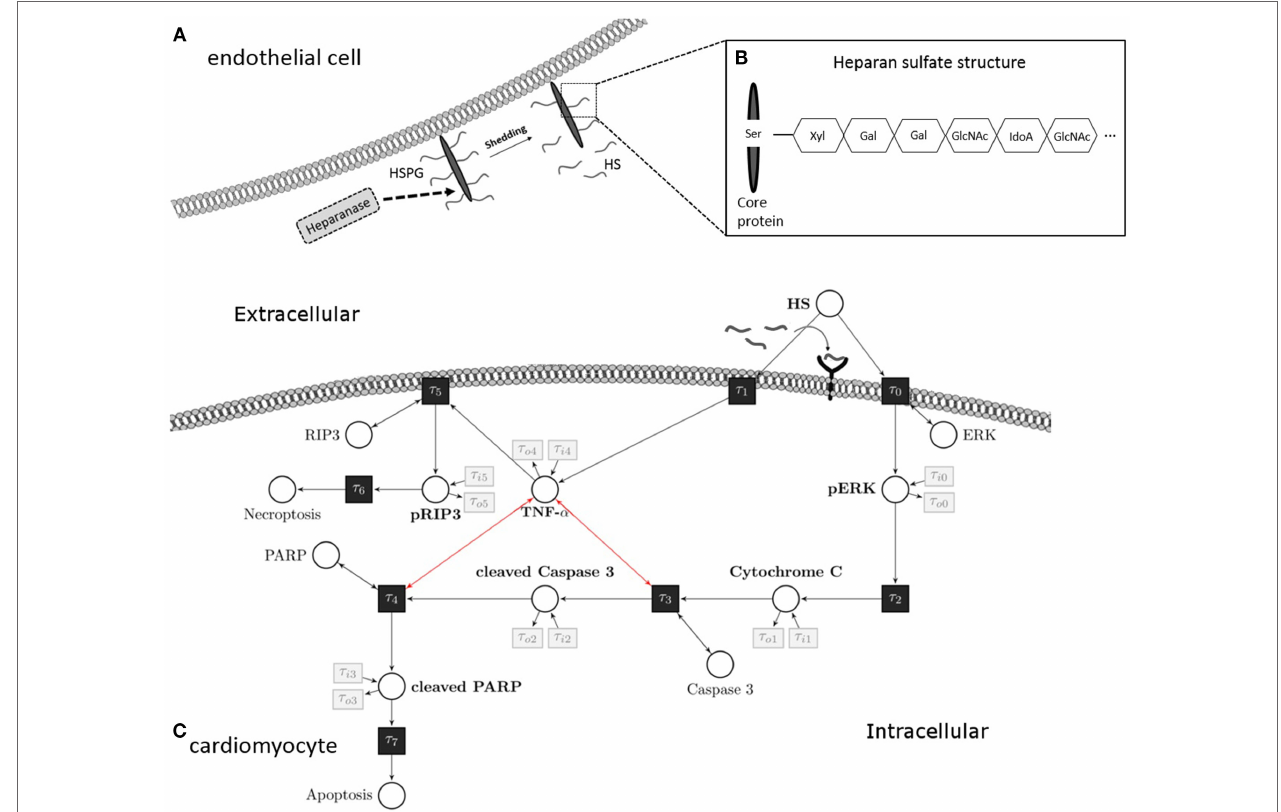
FIGURE 1 | Heparan sulfate induces an apoptosis/necroptosis signal pathway. (A) HS fragments are cleaved by heparanase from a HS proteoglycan, which is localized on the plasma membrane of endothelial cells. (B) Structure of HS proteoglycan. (C) HS interacts with a pattern recognition receptor (i.e., toll-like receptor 4) localized on the cell surface of cardiomyocytes and activates a pro-apoptotic intrinsic pathway. The signaling cascade involves phosphorylation of ERK 1/2 resulting in the release of mitochondrial cytochrome C, which leads to cleavage and activation of caspase 3. In the next step of this pathway, PARP is cleaved and deactivated by activated caspase 3. Induction of TNF- α caused by HS inhibits the pro-apoptotic pathway and induces phosphorylation of RIP3 and necroptosis. These apoptosis and necroptosis signal pathways represent our Petri net model. White circles are places, and black rectangles are transitions. Unidirectional arcs indicate directed flows. Bidirectional arcs indicate read arcs, which influence transitions, but do not consume tokens. Modified from Martin et al., Sarrazin et al., and Maeda (13–15). HS, heparan sulfate; PARP, poly-(ADP-ribose) polymerase; ERK, extracellular signal-regulated kinase; RIP, receptor-interacting protein; TNF- α , tumor necrosis factor alpha; Ser, serine; Xyl, xylose; Gal, galactose; GlcNAc, N-acetylgalactosamine; IdoA, iduronic